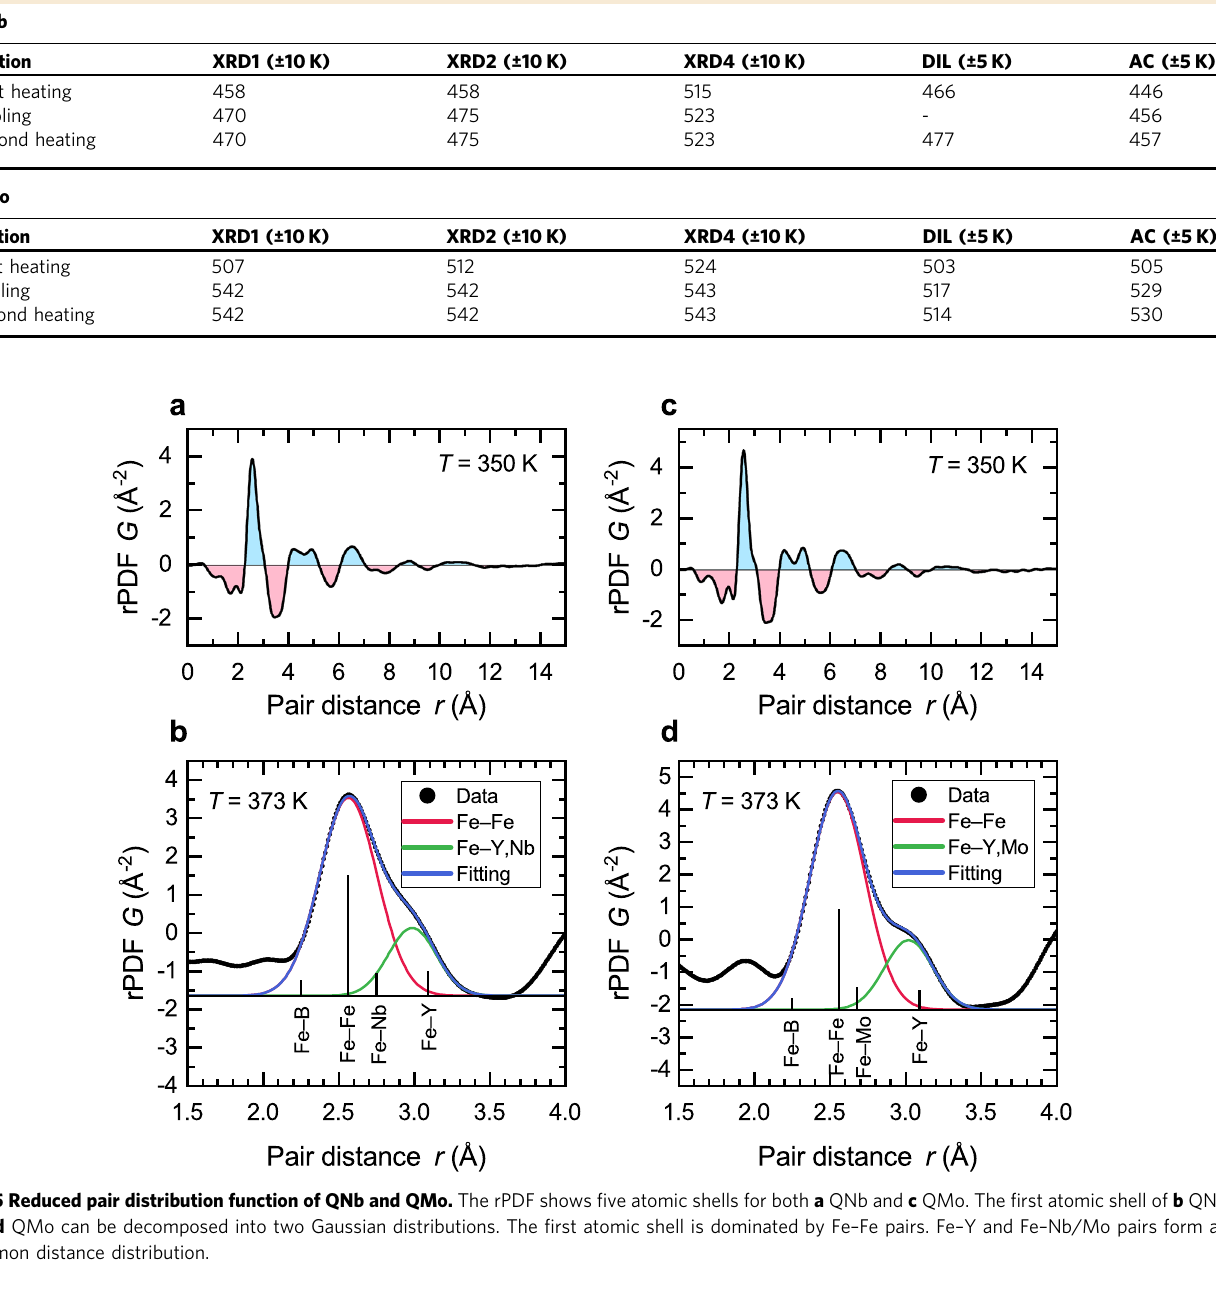
Table 2 Curie temperature and dilatometric transition temperature of QNb and QMo measured by XRD peaks (1, 2, and 4), dilatometry (DIL) and magnetometry